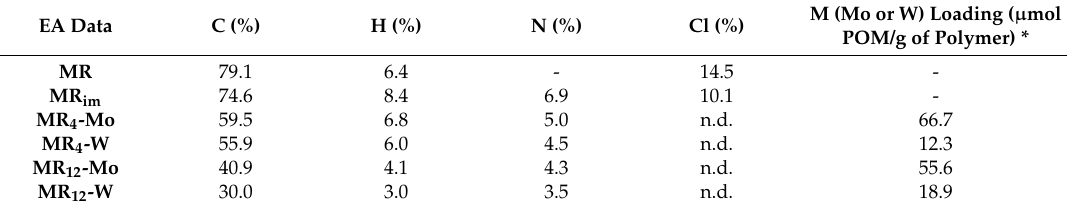
Table 2. CHN elemental analyses and metal loading. Figure 3. Solid ‐ state 31 P NMR of MR 4 ‐ W ( a ) and MR 12 ‐ W ( b ) supported catalysts.